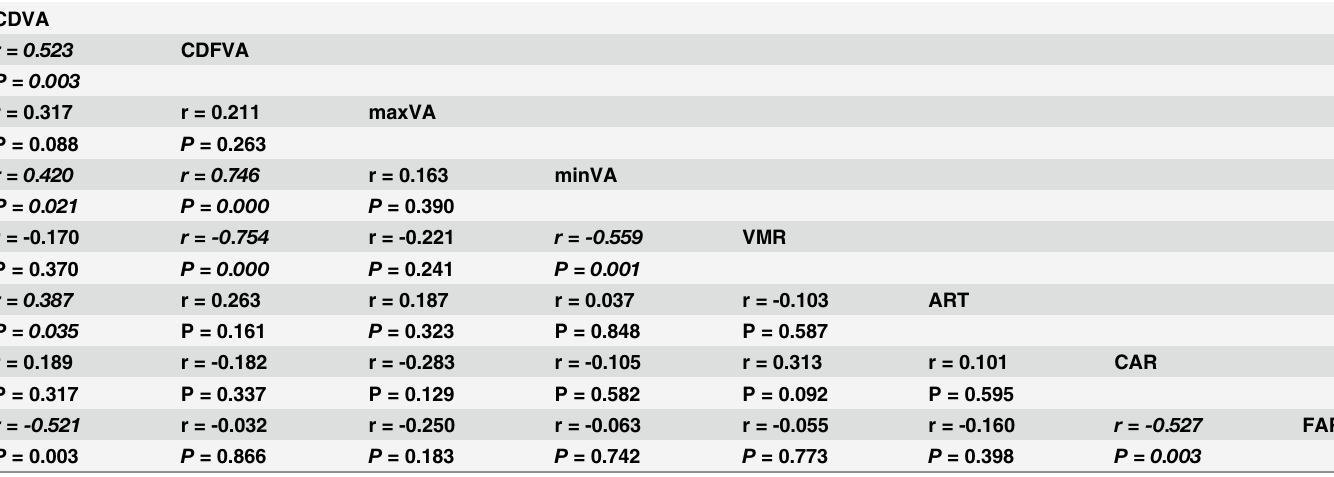
Table 4. Spearman rank correlation of the CDVA, parameters of the CDFVA, and the VFIT-EV with each other in the control group (n = 30) * .